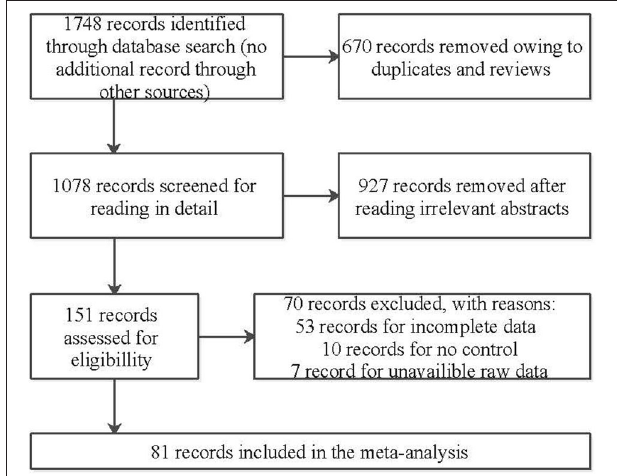
FIGURE 1 | Flowchart of study selection in our